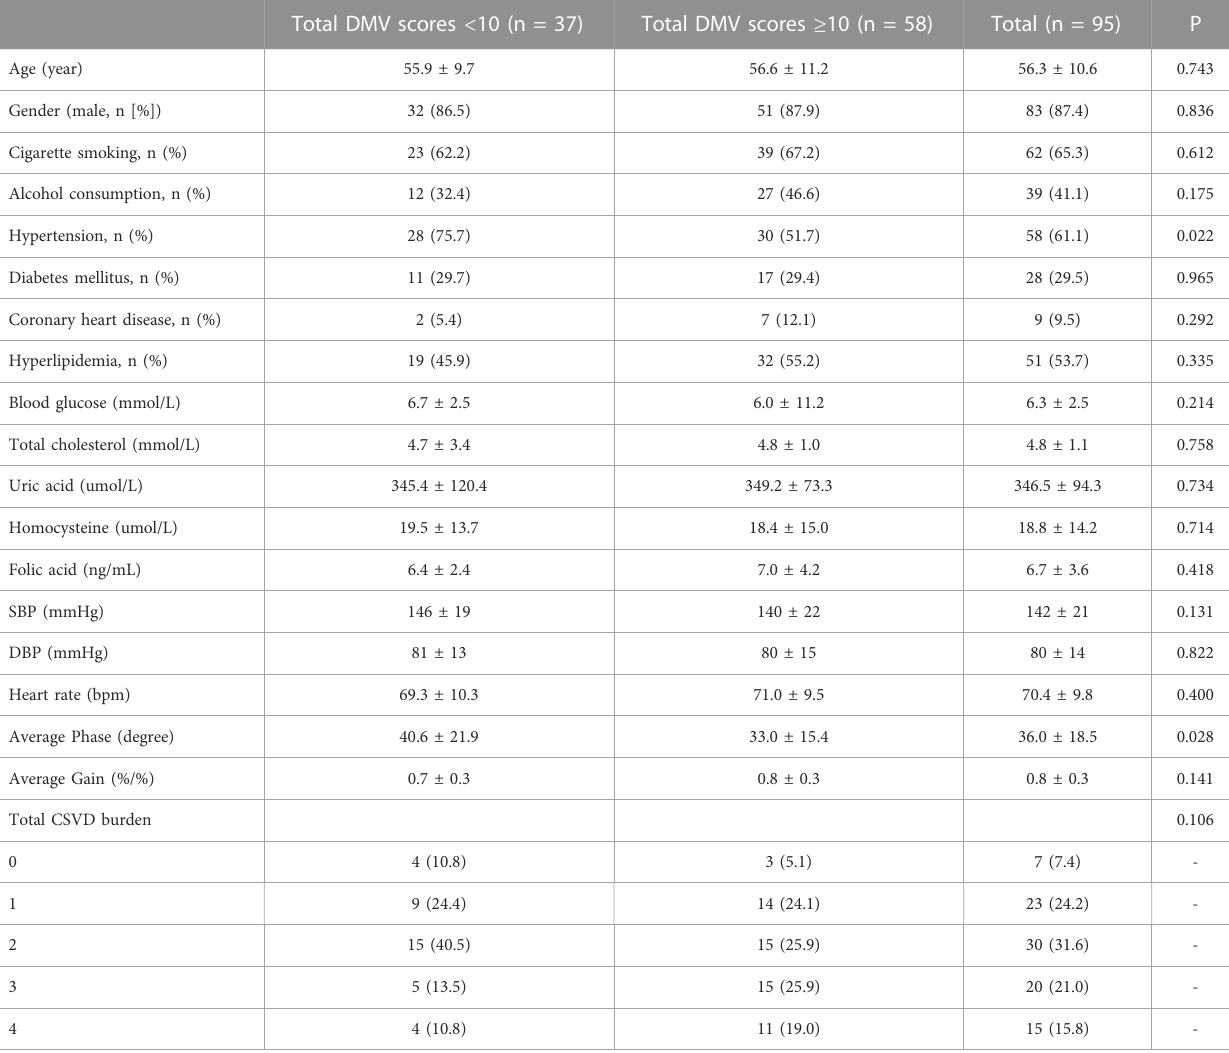
TABLE 1 Baseline characteristics of total patients and patients across categories of DMV